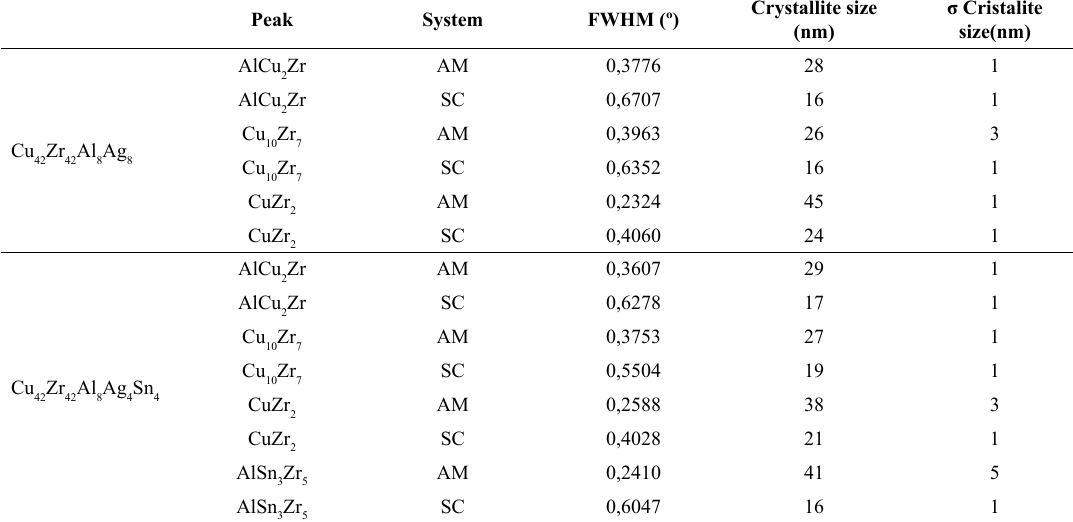
Table 1. Results of full width at half maximum (FWHM) and crystallite sizes for arc-melted (AM) and suction-casted (SC) systems, with uncertainties (σ). Peak